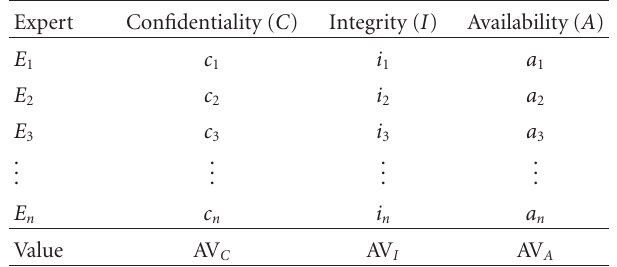
Table 11: Asset value.